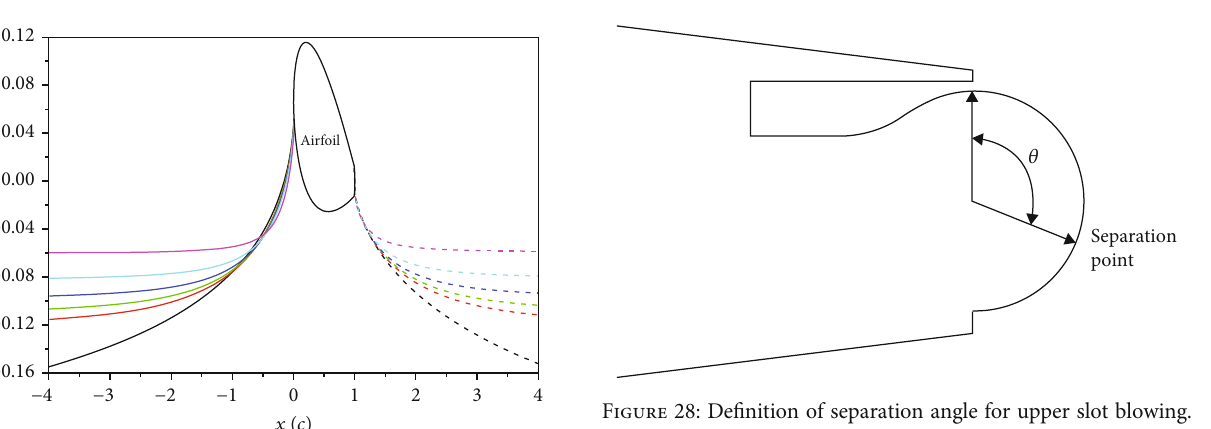
Figure 26: Pressure coe ffi cient of the CC airfoil for blowing with C coe ffi cient of the Coanda surface.